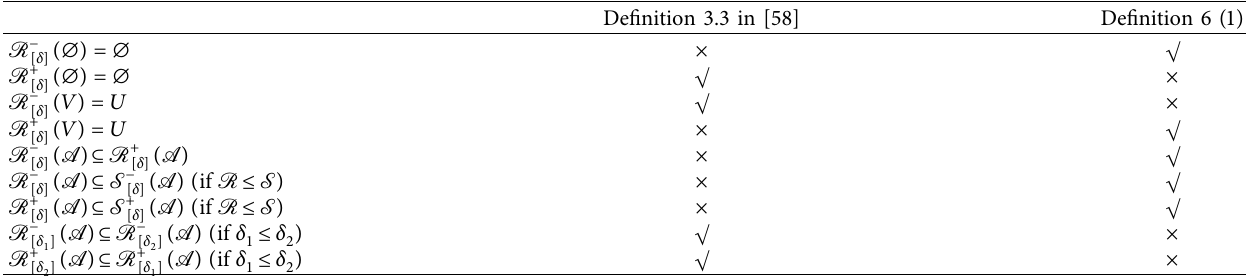
Table 1: Comparison between some properties by Definition 3.3 in [58] and 6